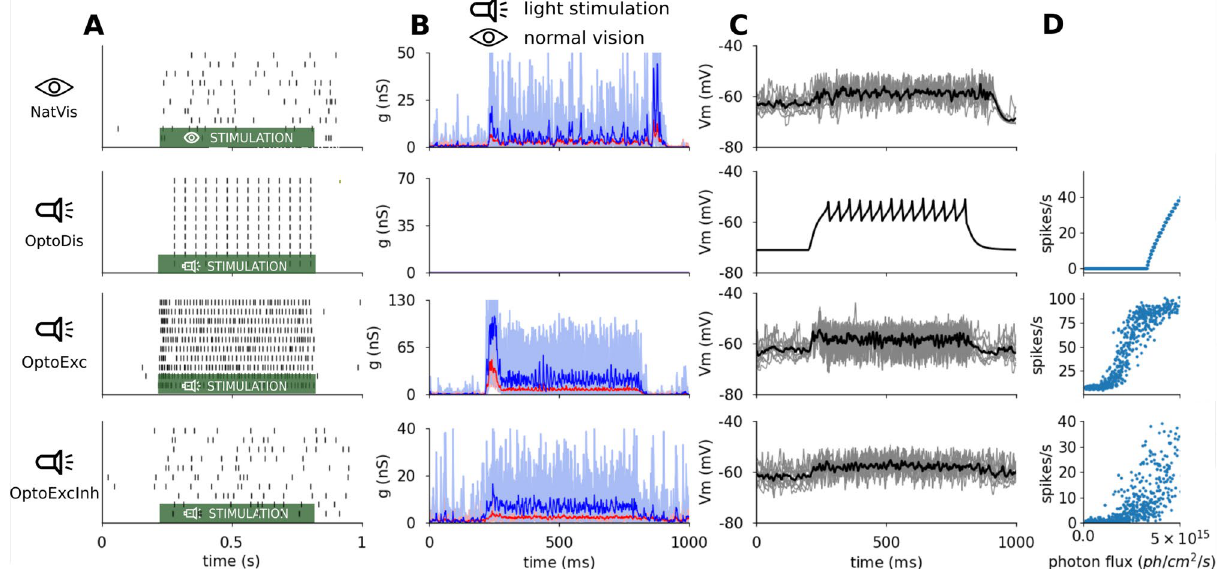
Figure 4. Example single-neuron dynamics in the 4 experimental conditions. The neurons respond to 10 trials of stimulation with a drifting sinusoidal grating or its light-stimulation equivalent, that starts at 200 ms and stops at 800 ms. From top to bottom NatVis, OptoDis, OptoExc, and OptoExcInh conditions. ( A ) Spike raster plot. ( B ) Excitatory (red) and inhibitory (blue) conductances. ( C ) Membrane potential. ( D ) The relationship between photon-flux and the spiking response of neurons in the given condition. In ( B ) and ( C ) pale thin lines are single-trials, thick saturated lines are mean across trials. In all three optogenetic conditions an arbitrary 9.2 10 15 photons/s/cm 2 was stimulation scaling factor of L max = ×